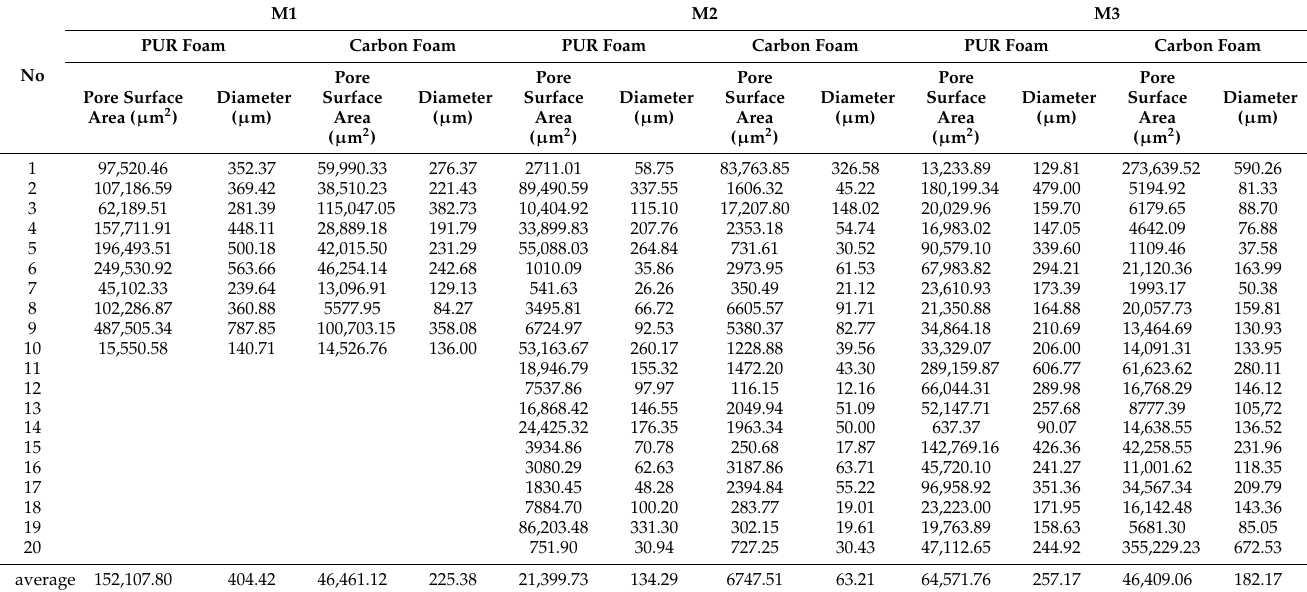
Figure 7. Micrograph of PUR foam ( A ) and carbon foam ( B ) taken with a light microscope-sample M3. Table 3. Results of measurements of pores with their average values for individual samples before and after the carbonization